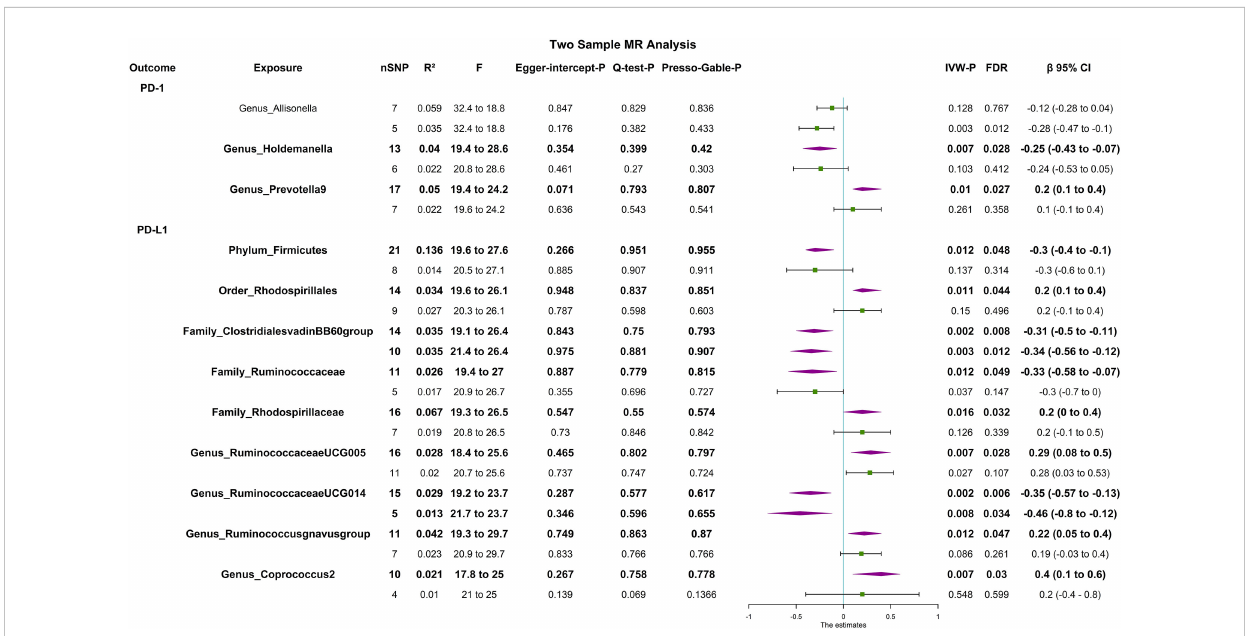
FIGURE 2 Forest plot of causal relationships estimated and sensitivity analysis for genus-level microbes and PD-1/PD-L1, the signi fi cant result (P FDR <0.05) by the IVW method in forward two-sample MR analysis (includes two thresholds). The words in bold type indicate signi fi cant results. CI, con fi dence interval; F, F-statistics; R 2 , the genetic variants for instrument; IVW, inverse variance weighted.